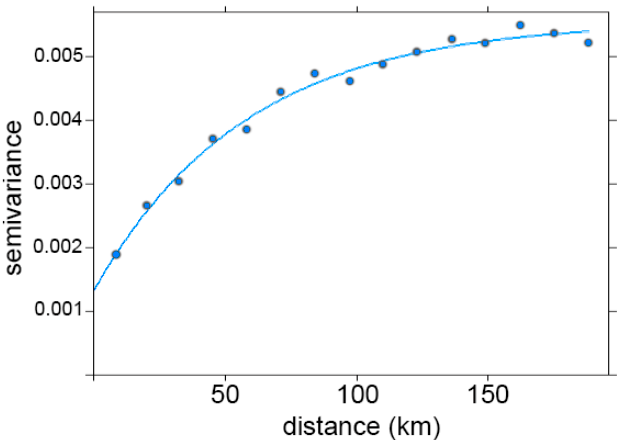
Figure 8. Spatial distribution of the parameter 𝛽 over Andalusia.